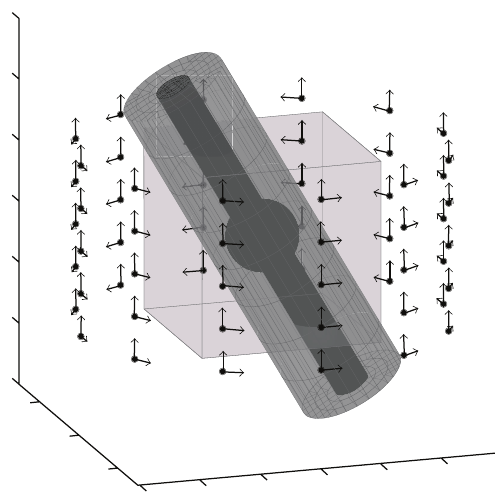
Figure 7: A view on the numerical child’s arm phantom, the investigation domain D , and the dipole configuration. Dipole positions are indicated with dots and orientations with arrows. All dipoles act as transmitters and receivers. Distances are expressed in background